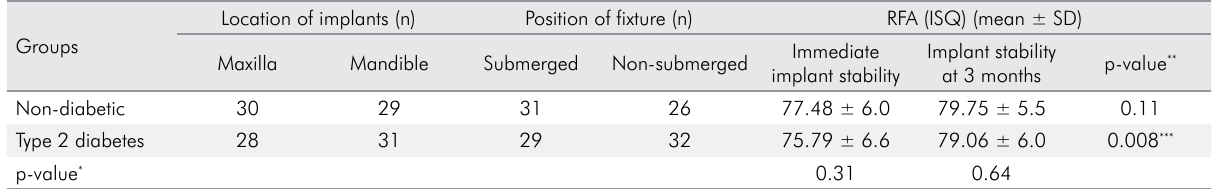
Table 2. Location, position, and stability of dental implants at baseline and at 3 months. Means of the resonance frequency analysis (RFA) are expressed in implant stability quotient